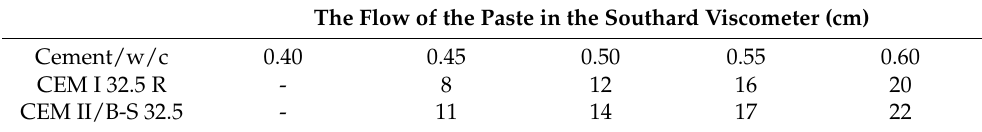
Table 4. The flow of the paste in the Southard viscometer. The Flow of the Paste in the Southard Viscometer (cm)